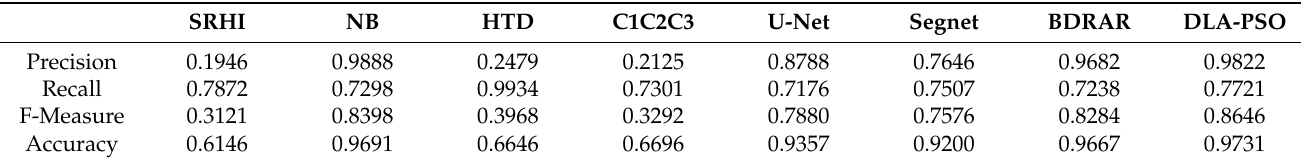
Table 6. Tyrol shadow-test-evaluation